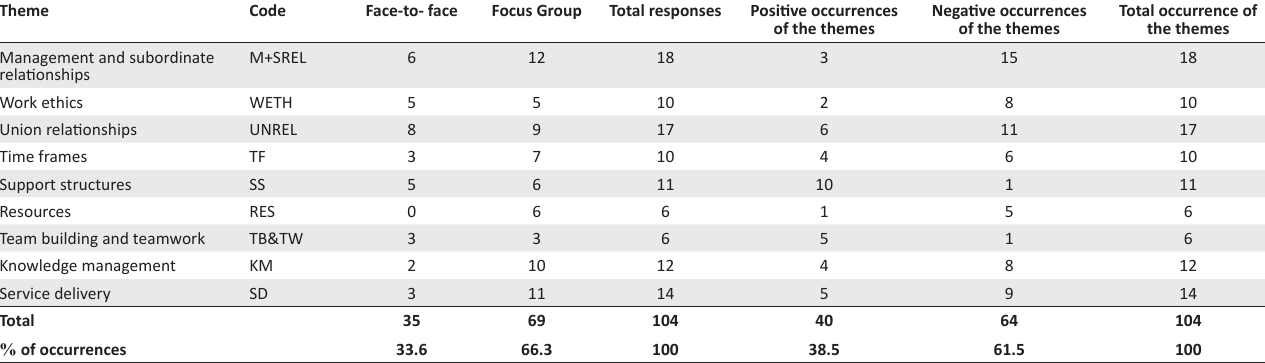
TABLE 8: Quantified qualitative outcomes of themes for Cluster 3: Performance environment.